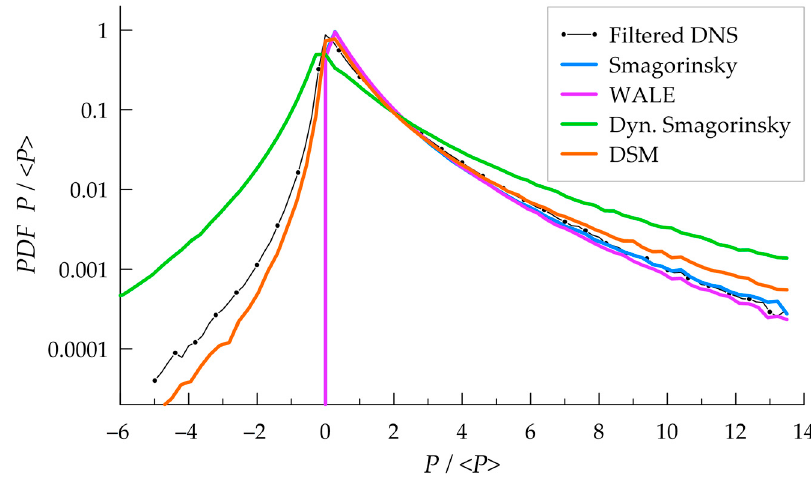
Figure 5. Normalized probability density function of scale-to-scale energy flux.